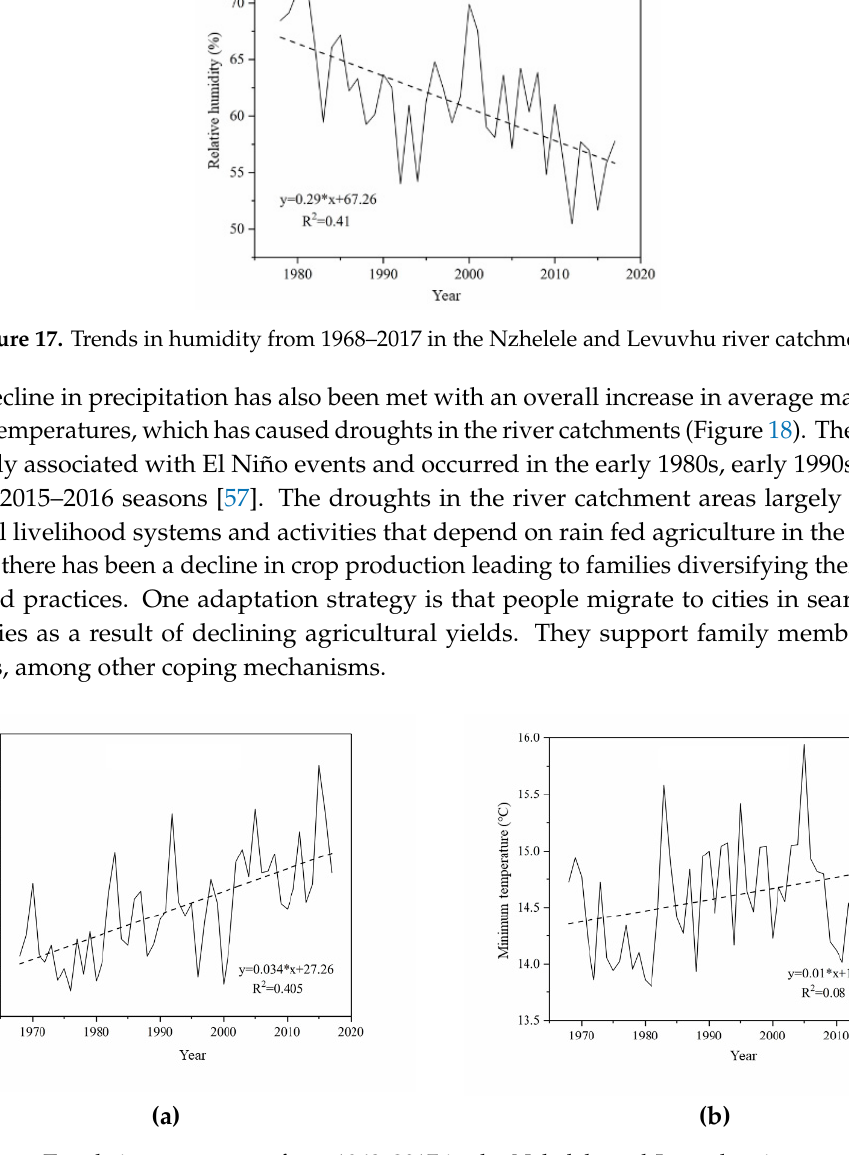
Figure 18. Trends in temperature from 1968–2017 in the Nzhelele and Levuvhu river catchments, ( a ) maximum temperature and ( b ) minimum temperature.